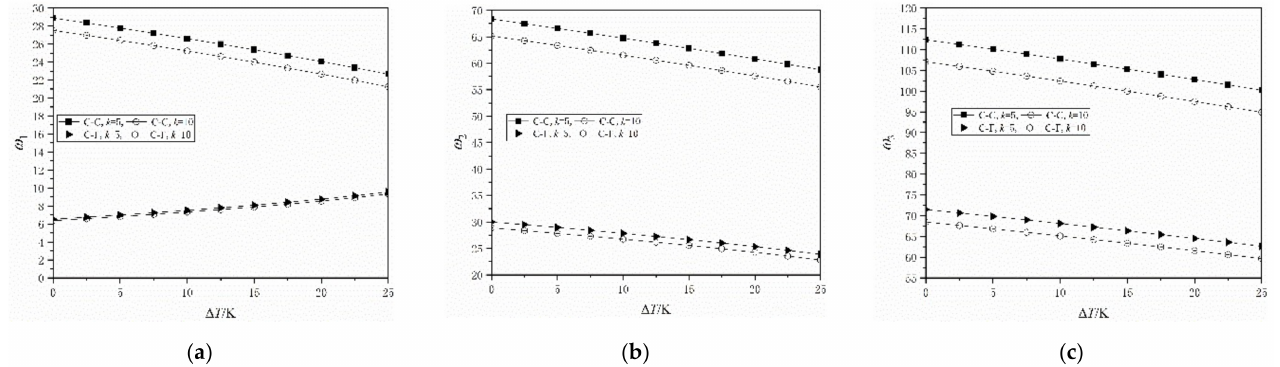
Figure 9. The relationship between dimensionless natural frequencies and the temperature change under two different boundary conditions (Mindlin plate). ( a ) The first-order frequencies; ( b ) The second-order frequencies; ( c ) The third-order frequencies.